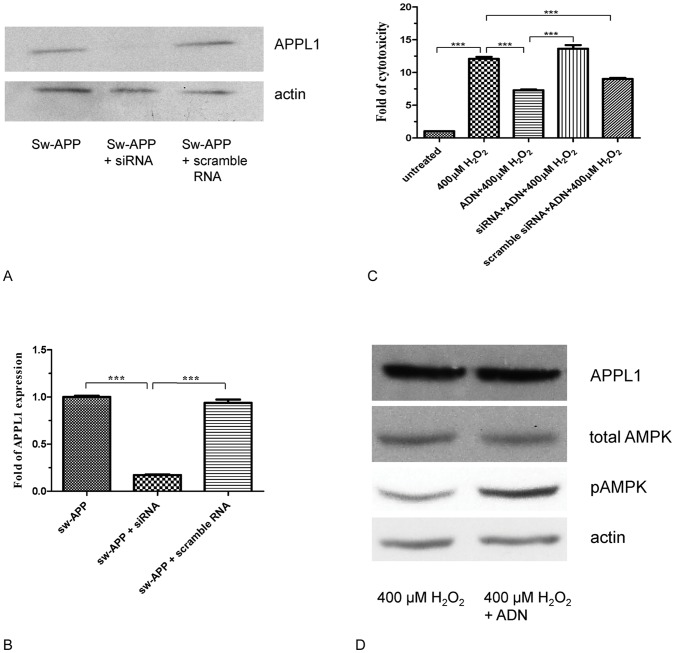
Adiponectin neuroprotection against cytotoxicity under oxidative stress is mediated via APPL1-dependent AMPK activation.
A. Western blot analysis of control Swedish-APP mutant transfected SH-SY5Y cells (Sw-APP) and similar cells transfected with scramble RNA (Sw-APP+scramble RNA) revealed APPL1 expression. Successful knowkdown of APPL1 expression by RNA interference was shown on immunoblotting of cell lysate of Sw-APP transfected SH-SY5Y cells transfected with short interference RNA for APPL1 (Sw-APP+siRNA). B. Image-J analysis confirmed successful knockdown of APPL1 expression in Sw-APP transfected SH-SY5Y cells by siRNA compared to control cells transfected with scramble RNA (p<0.0001). Transfection experiments were performed 3 times with consistent results. C. Neuroprotective effect of adiponectin against cytotoxicity under oxidative stress (400 µM H2O2) was lost in Sw-APP transfected SH-SY5Y cells with knockdown of APPL1 expression (siRNA+ADN+400 µM H2O2), but preserved in cells without knockdown of APPL1 expression (scramble siRNA+AND+400 µM H2O2, p<0.0001). This suggests that adiponectin neuroprotection against Aβ-induced cytotoxicity under oxidative stress requires APPL1. Fold of percentage cytotoxicity relative to cells not exposed to H2O2 (untreated, fold = 1) was shown on y-axis. untreated = Sw-APP transfected SH-SY5Y cells without exposure to H2O2, 400 µM H2O2 = Sw-APP transfected SH-SY5Y cells exposed to 400 µM H2O2, ADN+400 µM H2O2 = Sw-APP transfected SH-SY5Y cells pretreated with adiponectin before exposure to 400 µM H2O2. Results shown were mean values from 3 independent cultures, and compared by one-way ANOVA using Newman-Keuls multiple comparison test. D. Adiponectin induced AMPK activation. Western blot analysis of cell lysates from Sw-APP transfected SH-SY5Y cells exposed to oxidative stress (400 µM H2O2) demonstrated that cells pretreated with adiponectin (ADN) had increased phosphorylated AMPK (pAMPK) compared to cells without adiponectin pretreatment whereas APPL1 and total AMPK levels were similar. This strongly suggests that adiponectin neuroprotection against cytotoxicity under oxidase stress in Sw-APP transfected SH-SY5Y cells is mediated via APPL1-dependent AMPK activation. Western blot analysis were performed for 3 independent cultures with consistent results.